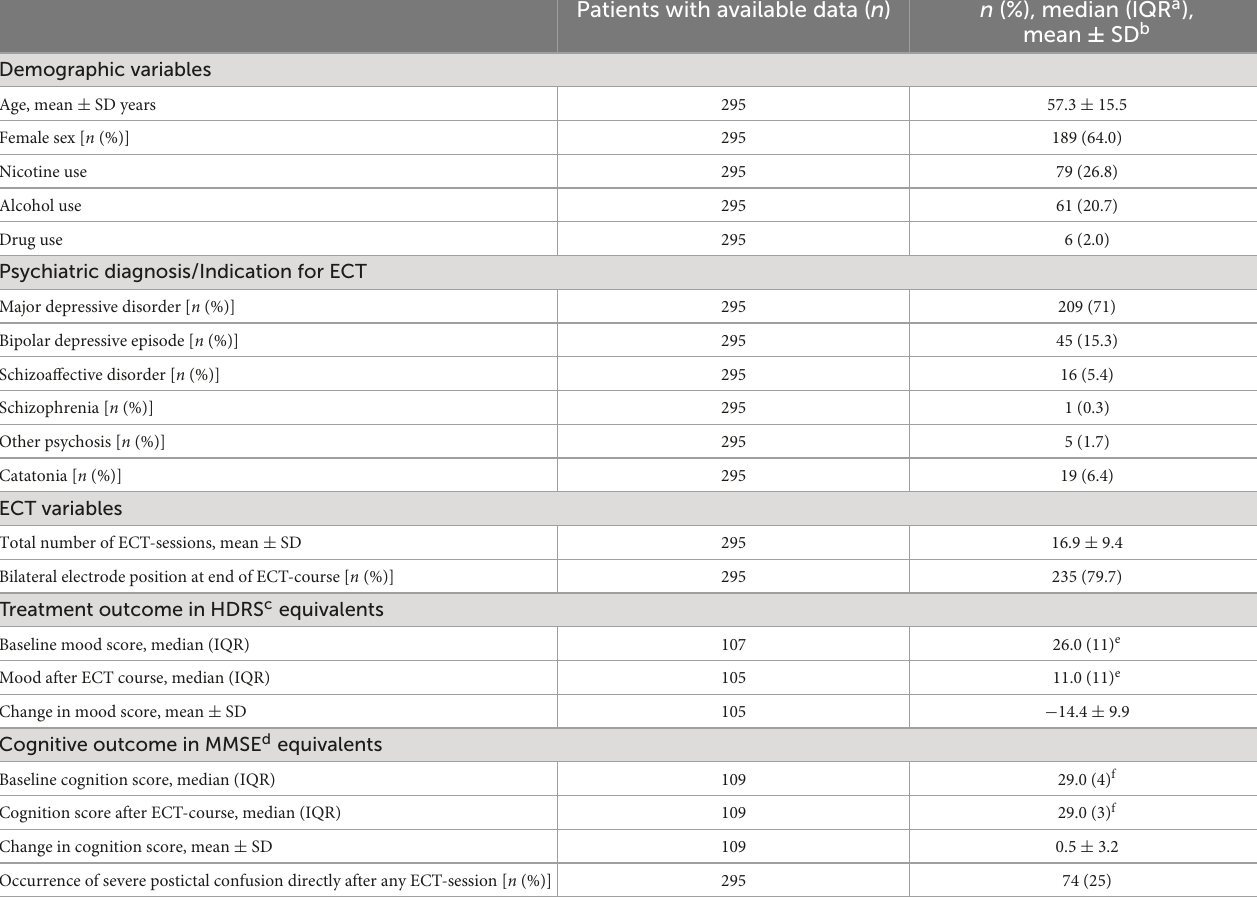
TABLE 1 Patient-, treatment-, and outcome characteristics in 295 patients who were treated with electroconvulsive therapy (ECT). Patients with available data ( n